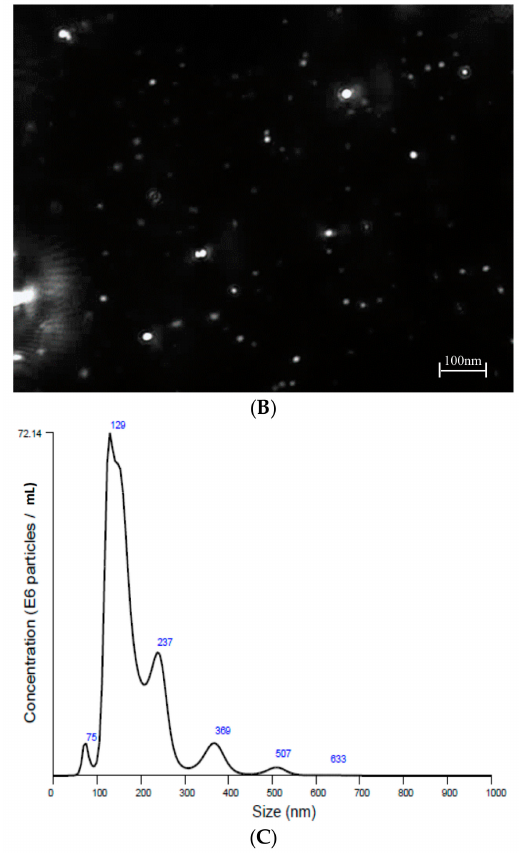
Figure 4. ( A ) A graphic representation of the nanoparticle tracking analysis (NTA) principle; ( B ) An image of EVs secreted by tumors cells of the gastric cancer cell line GC1401 acquired by the NTA system; ( C ) The corresponding EVs size